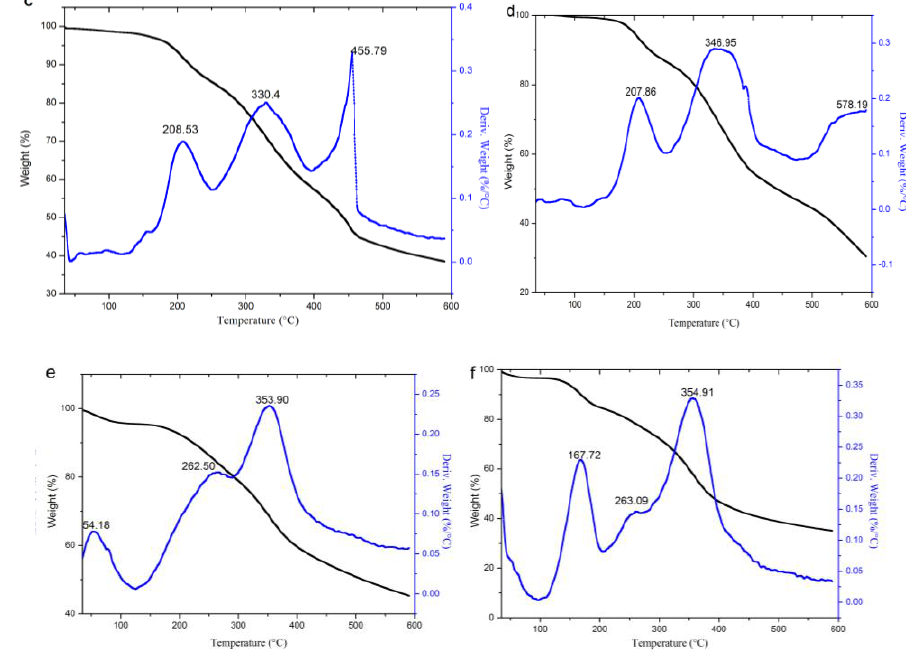
Figure 8. TG analysis of lignin and its esters: ( a ) original lignin; ( b ) acetylated lignin (1.5 h); ( c ) propionylated lignin (1.5 h); ( d ) butyrated lignin (2 h); ( e ) succinylated lignin (2 h); ( f ) maleylated lignin (2 h).